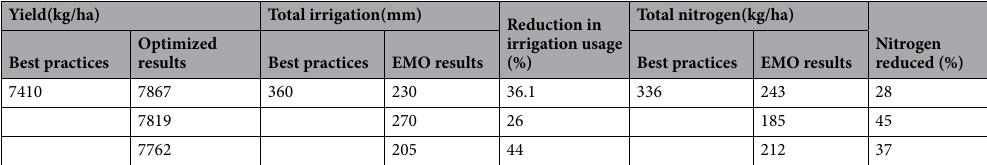
Table 3. Comparison of best simulated irrigation and nitrogen experimental results (ranked by yield) and the best